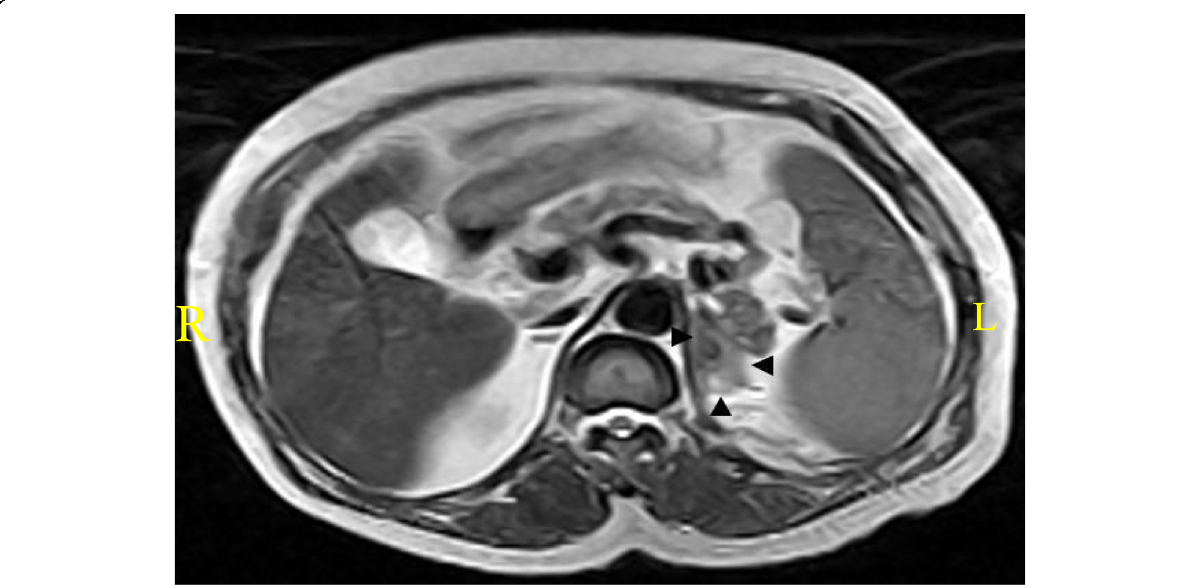
Fig. 3 Axial T2WI MRI of the abdomen showing micro-lobulated soft tissue lesion arising from left suprarenal gland (arrow heads) displaying heterogeneous SI at